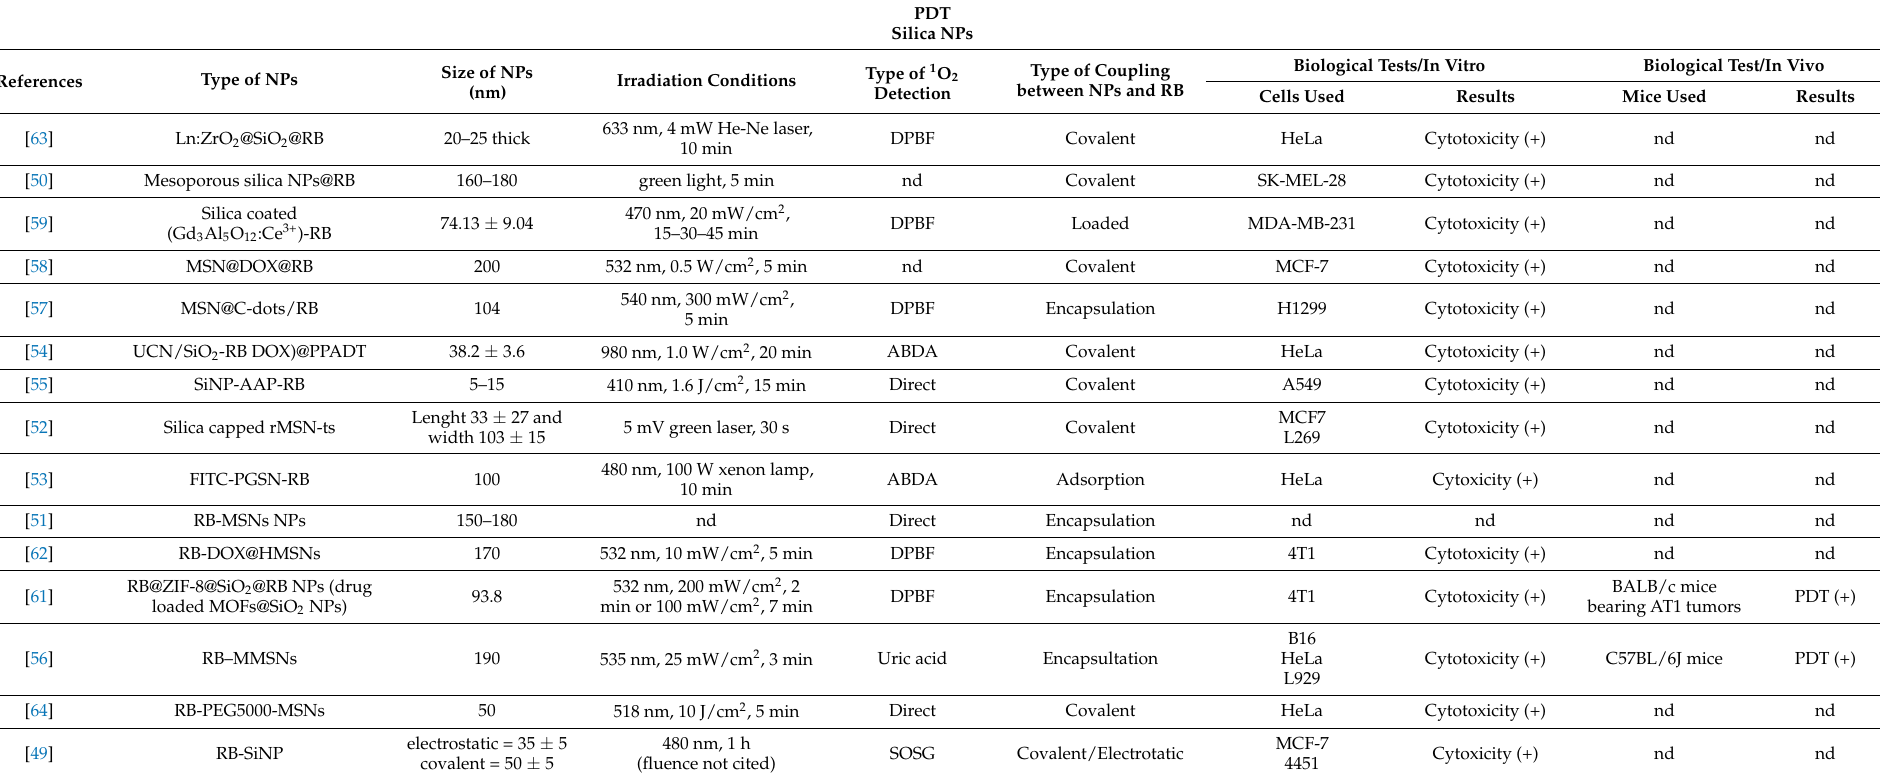
Table 2. Table summarizing the references dealing with silica NPs@RB, including the type of NPs, as well as their size, excitation wavelength, type of detection of 1 O 2 , type of coupling between the NPs and the RB, and the type of biological experiments